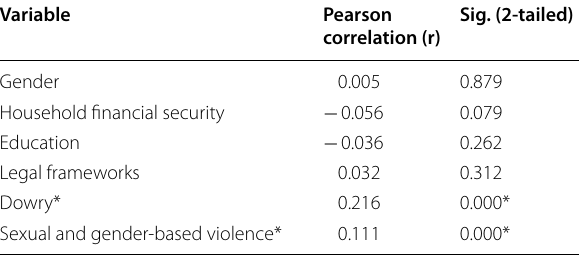
Table 6 Bivariate correlation (Pearson correlation)